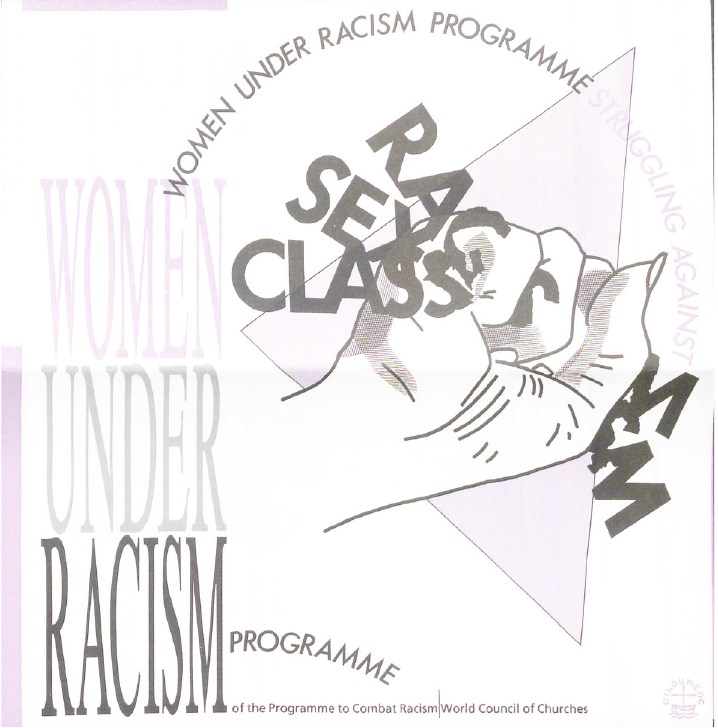
Figure 1: Cover of the official WUR flyer. SISTERS box. Image by author, May